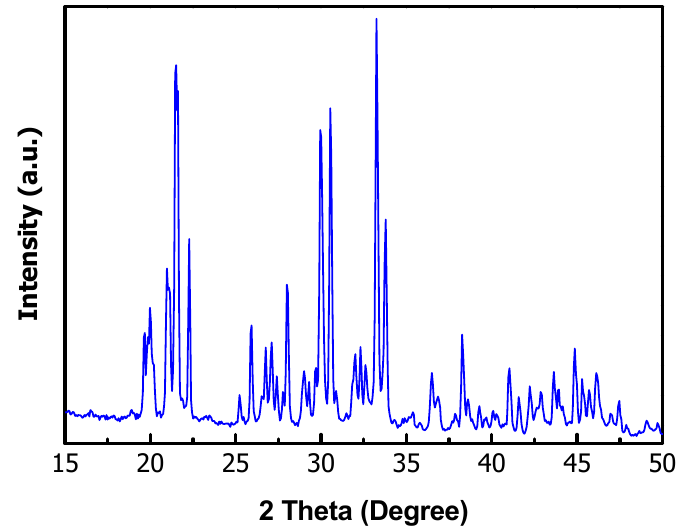
Figure 2. X-ray powder diffraction pattern of Na 2 CaP 2 O 7 . and 888 cm − 1 are defined as the symmetrical (sym) and antisymmetric (anti) vibration of P-O-P, respectively. These bands confirm the presence of pyrophosphate P 2 O 7 groups. Two fields share the associated vibrations of the PO 4 groups: a symmetrical vibration field (997 cm − 1 , 1031 cm − 1 ) and the other from 1112 cm − 1 to 1278 cm − 1 . The described bands confirm that Na 2 CaP 2 O 7 was